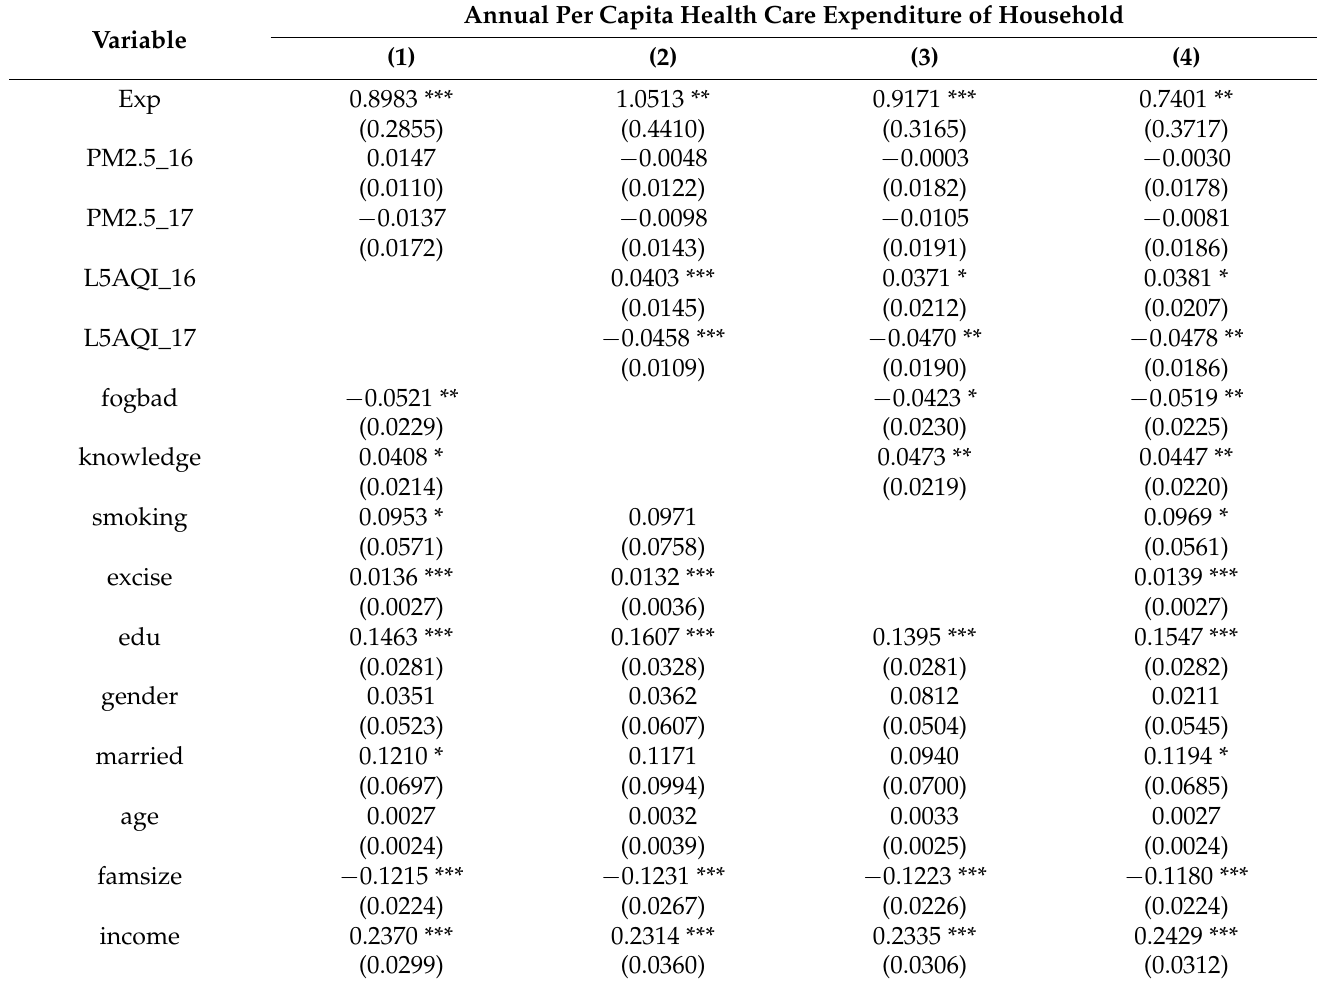
Table 4. Impact of smog avoidance expenditure on household health care